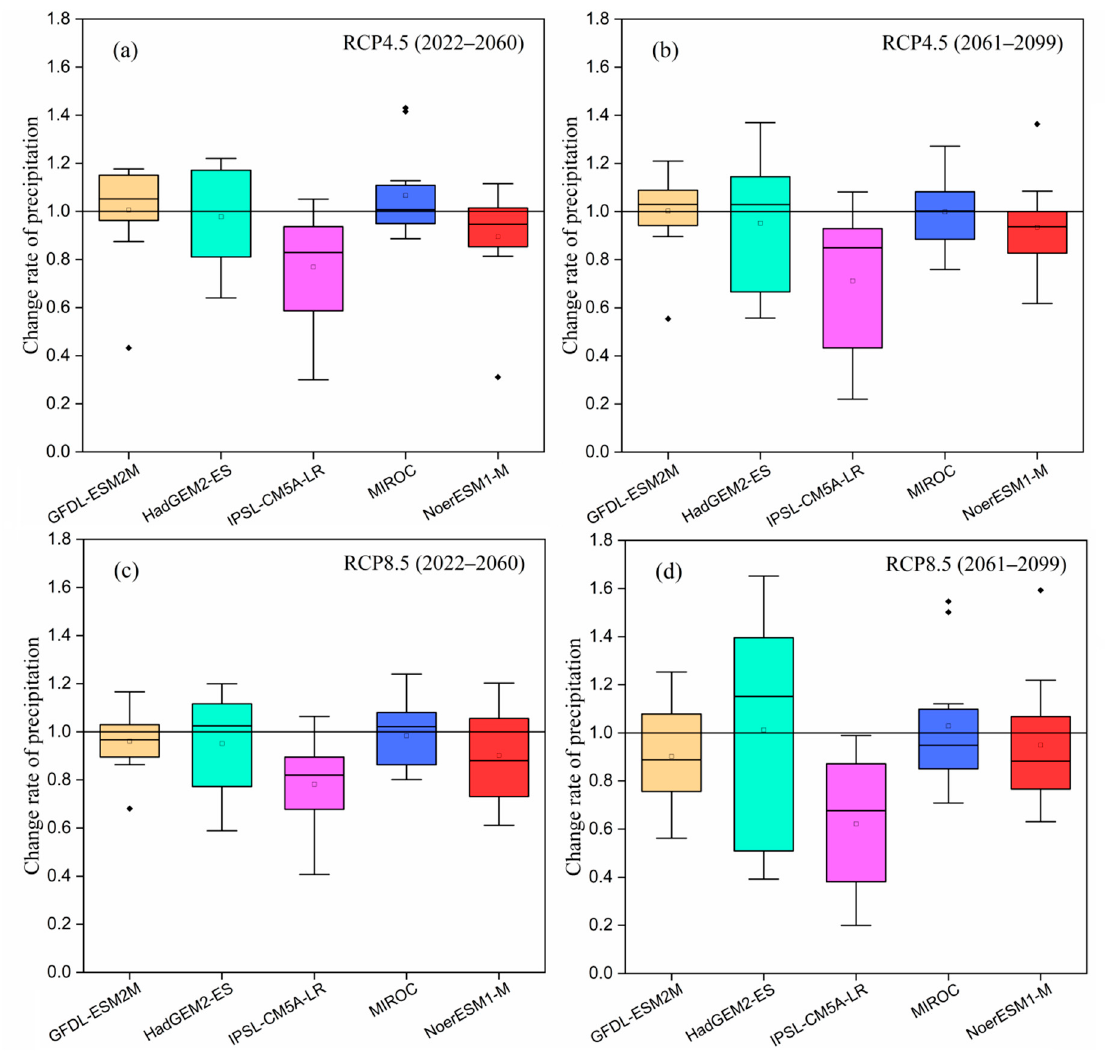
Figure 7. Box-and-whisker plots of the precipitation changes of the GCMs during the 2022–2060 and 2061–2099 periods under RCPs 4.5 and 8.5 in the Vakhsh River Basin, Central